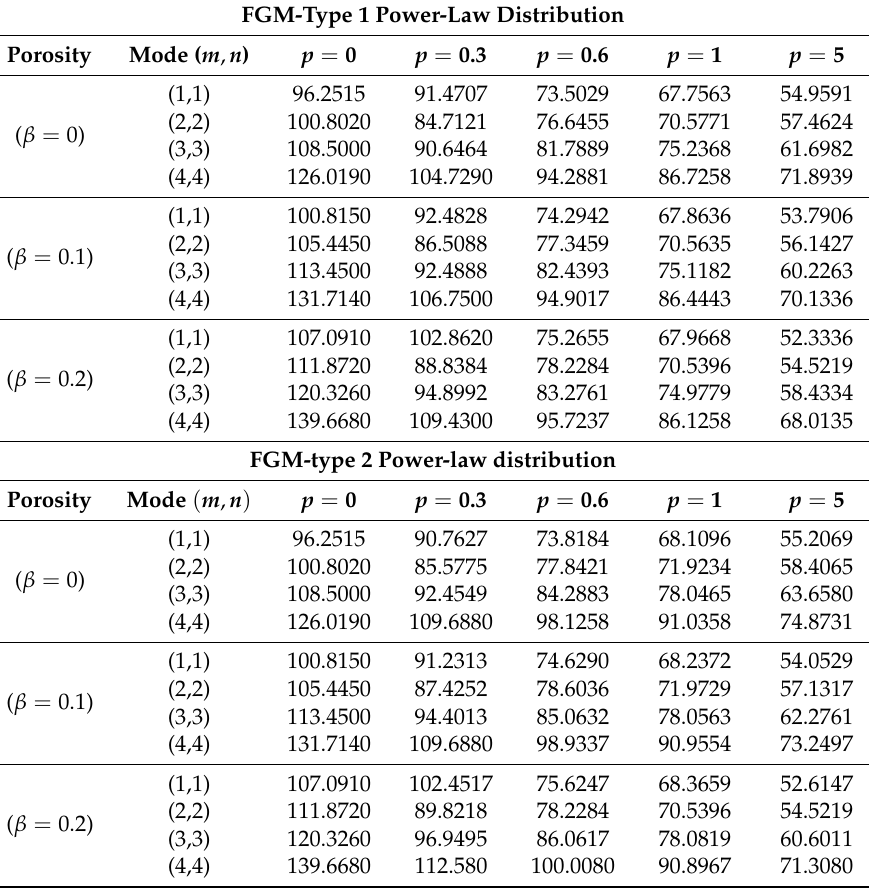
Table 3. Dimensionless frequency of simply-supported (SSSS) functionally graded porous spherical shell as functions of the power-law index and porosity volume fraction. FGM: Functionally Graded